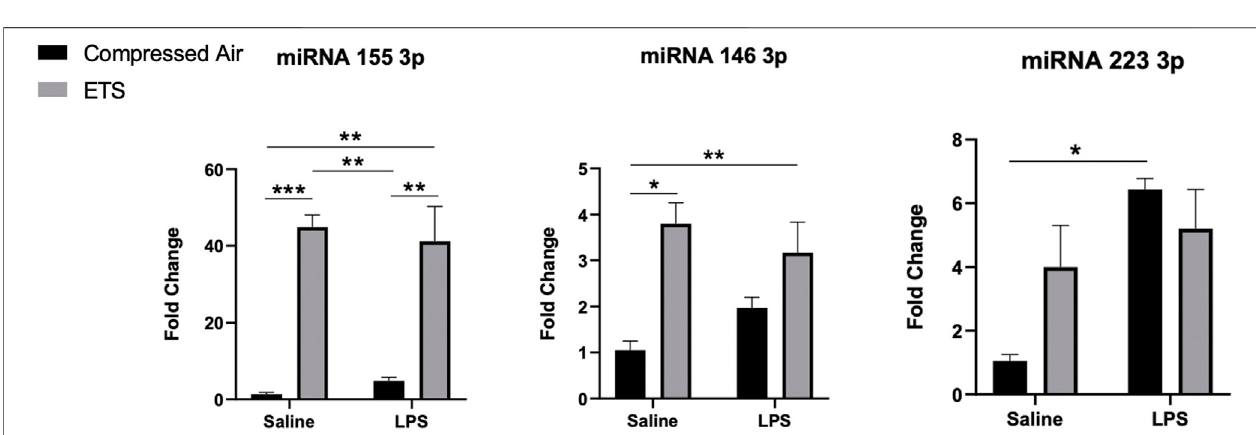
FIGURE 4 | Evaluation of miRNA in enhanced glial cell culture from C57Bl/6 mice offspring exposed or not to environmental tobacco smoke in utero . After maturation, cells were challenged or not with LPS. Statistical analysis: Two-way ANOVA and Tukey ’ s post-hoc. Data are expressed as mean ± SEM. * p < 0.05, ** p < 0.01, *** p < 0.001, **** p < 0.0001. The black bar represents exposure to compressed air and gray bar represents exposure to